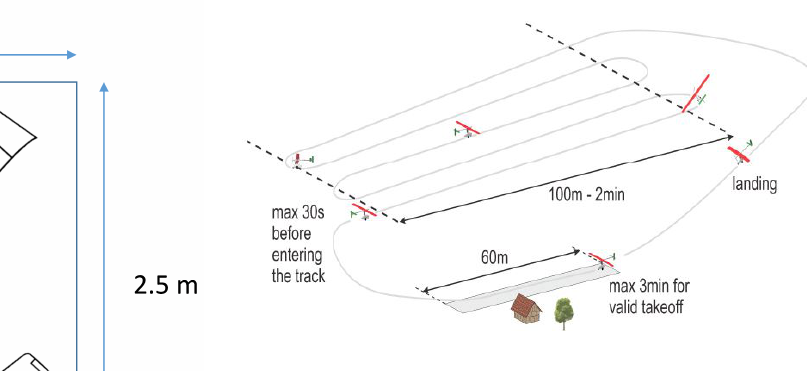
Figure 7: Take-off and cruise legs